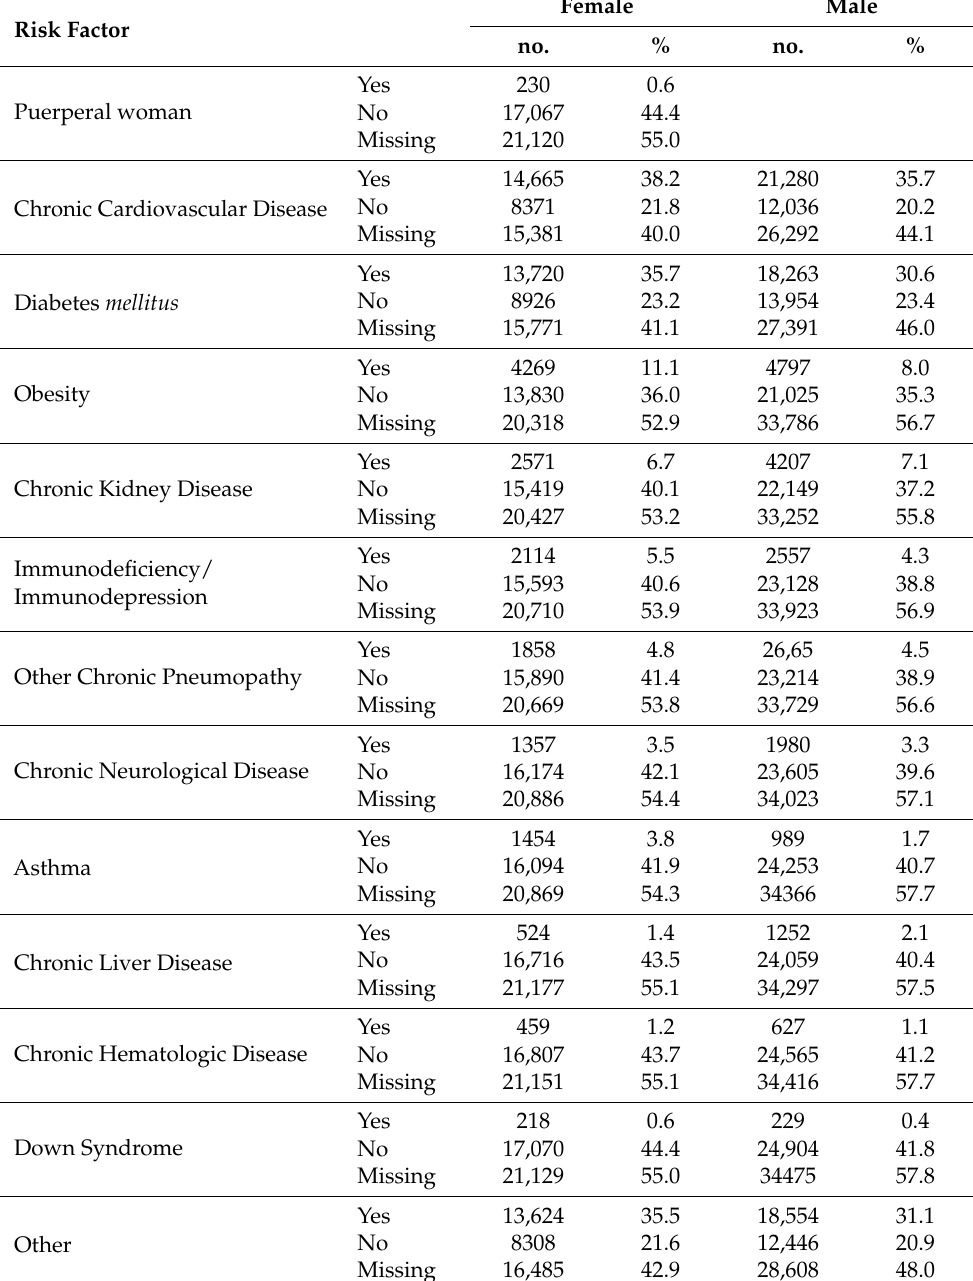
Table A4. Risk factors for gender in Brazil,